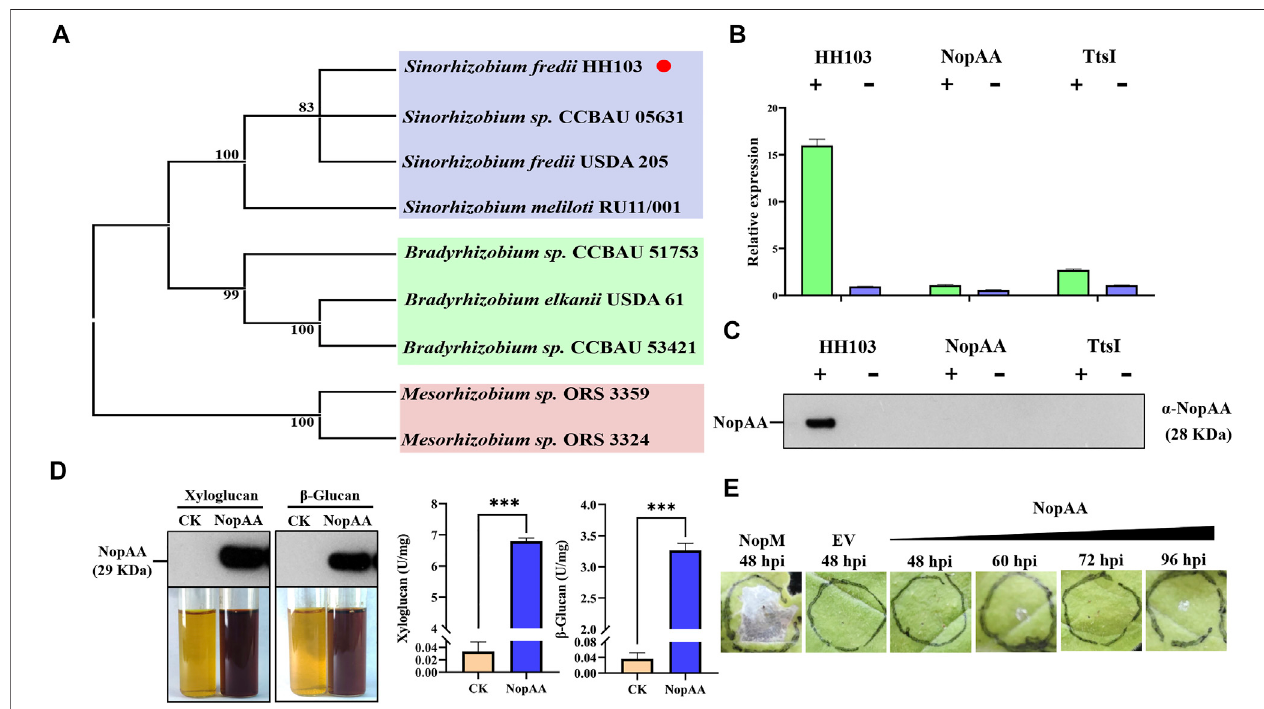
FIGURE 1 | NopAA is a rhizobial type III effector with glycoside hydrolase activity. (A) Phylogenetic tree analysis of NopAA proteins from different rhizobia. (B) RelativeexpressionofNopAAinrhizobiainthepresenceandabsenceofgenistein. (C) AnalysisofNopAA,anodulation-promotingouterproteinsecretedbyrhizobia,by immunoassayinthepresenceandabsenceofgenistein.In (B) and (C) ,"+"representsinductionbytheadditionofgenistein,and" − "representstheabsenceofgenistein. (D) Analysis of glycoside hydrolase activity ofNopAA. Pure xyloglucan and β -glucan were used as substrates for measuring enzyme activity, and NopAA protein in the reaction system was detected by immunoblotting. Data are presented as the average of three different biological replicates. (E) N. benthamiana leaves 48 h – 96 h after inoculation with EH105 carrying NopAA and positive control NopM